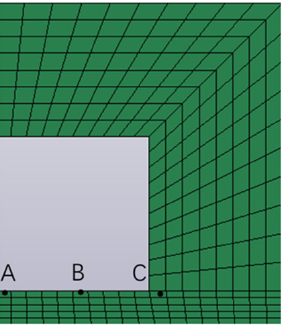
Figure 9. Monitoring points of rock blasting damage beneath the box